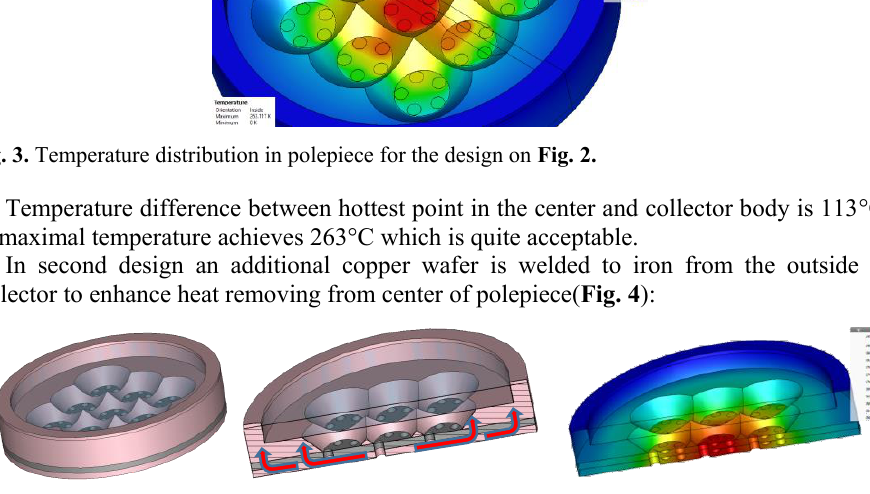
Fig. 4. The design with additional copper wafer and its temperature distribution .